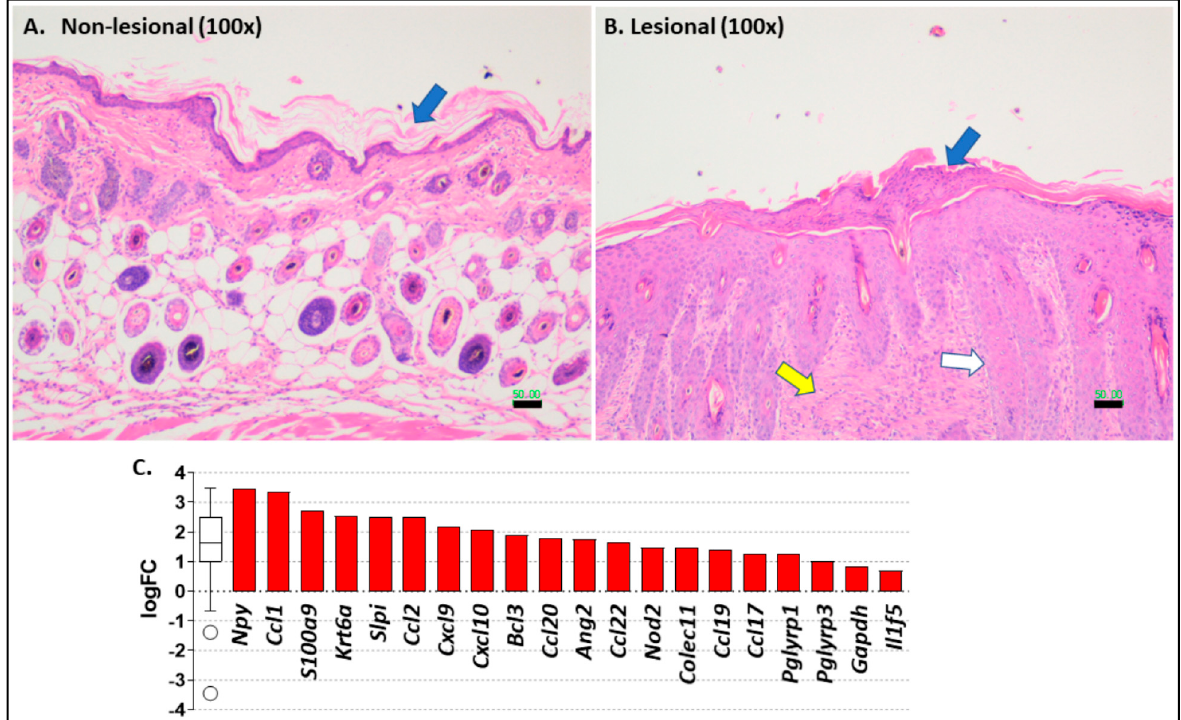
Figure 3. The cutaneous lesions in C57. Pparg -/- epi mice exhibit features consistent with an inflammatory dermatosis. ( A ) Representative photomicrograph of a hematoxylin & eosin (H&E) stain slide of non-lesional skin from a C57. Pparg -/- epi mouse. While hyperkeratosis was observed (blue arrow in A ), the epidermis did not exhibit evidence of hyperplasia, and no significant inflammatory infiltrate was observed. Sebaceous glands are also absent.Scale bar = 50 µm. ( B ) Representative H&E of lesional skin from a C57. Pparg -/- epi mouse. The lesions show areas of parakeratosis and intracorneal serum, neutrophils, and focal hemorrhage (blue arrow in B ). The epidermis was acanthotic and mildly spongiotic with subjacent proliferation of hair follicle epithelium (white arrow). Lesional skin was also associated with increased inflammatory infiltrates and areas of dermal fibrosis (yellow arrow). Scale bar = 50 µm. ( C ) The top 20 of 23 genes that mapped to the antimicrobial humoral response GO term are shown (iPathwayGuide, Advaita, GO:0019730; p -value = 1.64E-04). Gene mapping was restricted to genes that had a │ log2 FC │ > 0.6 at an FDR < 0.05. The Y -axis represents the log2 fold change (logFC). Up-regulated genes are shown in red columns. The box represents the 1 st quartile, the median and the 3 rd quartile for all genes in the GO term. The whiskers represent the minimum and maximum, and the circles represent the outliers.